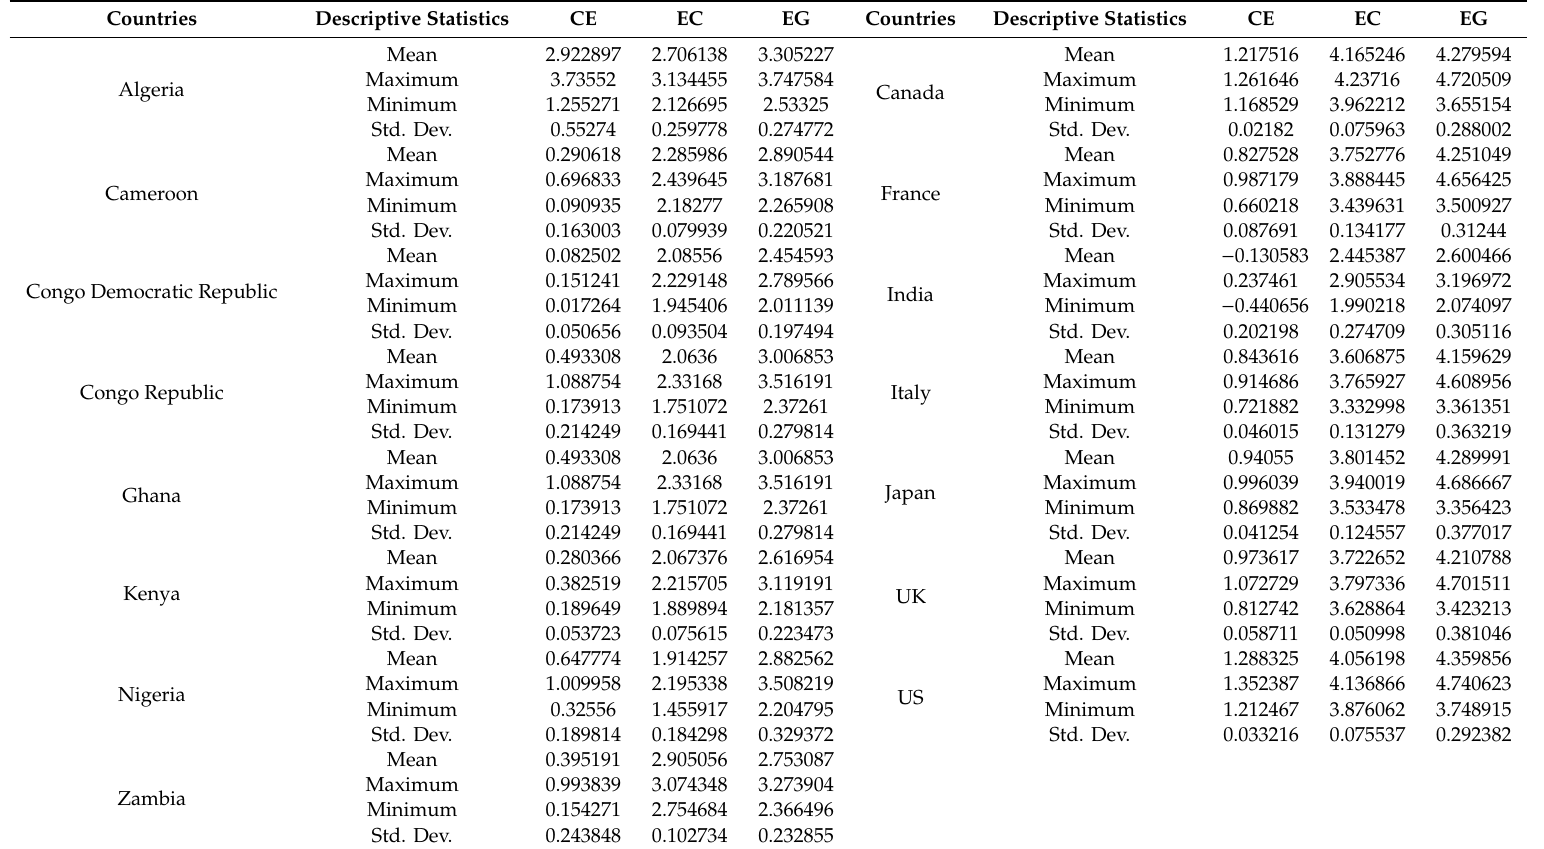
Table 2. Summary